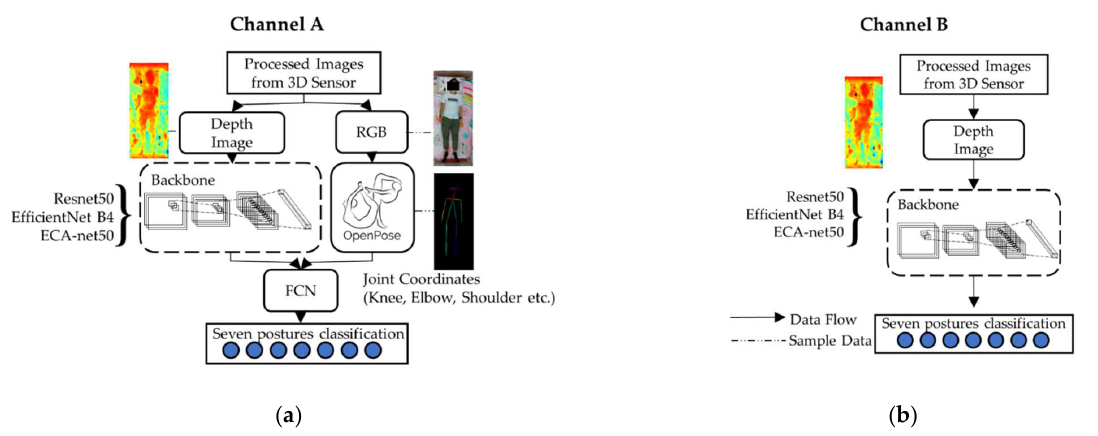
Figure 3. Model training architectures (system units) with the ResNet-34, EfficientNet B4, and ECA- Net50 backbones: ( a ) Channel A: with pose estimator; ( b ) Channel B: without pose